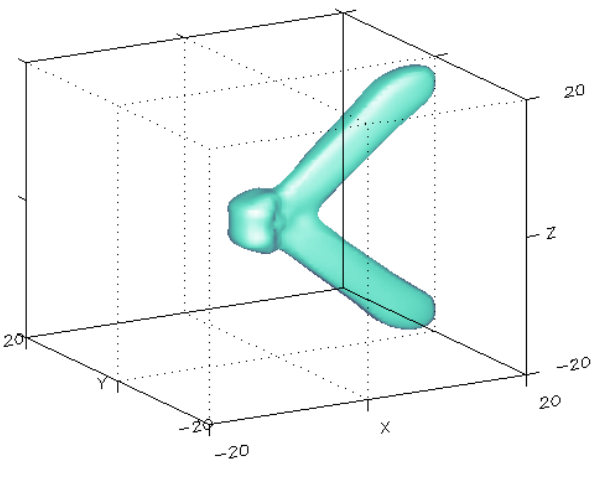
Fig. 1. 3-D structure of a pair of Alfv ´ en wings, illustrated as an isocontour plot of absolute